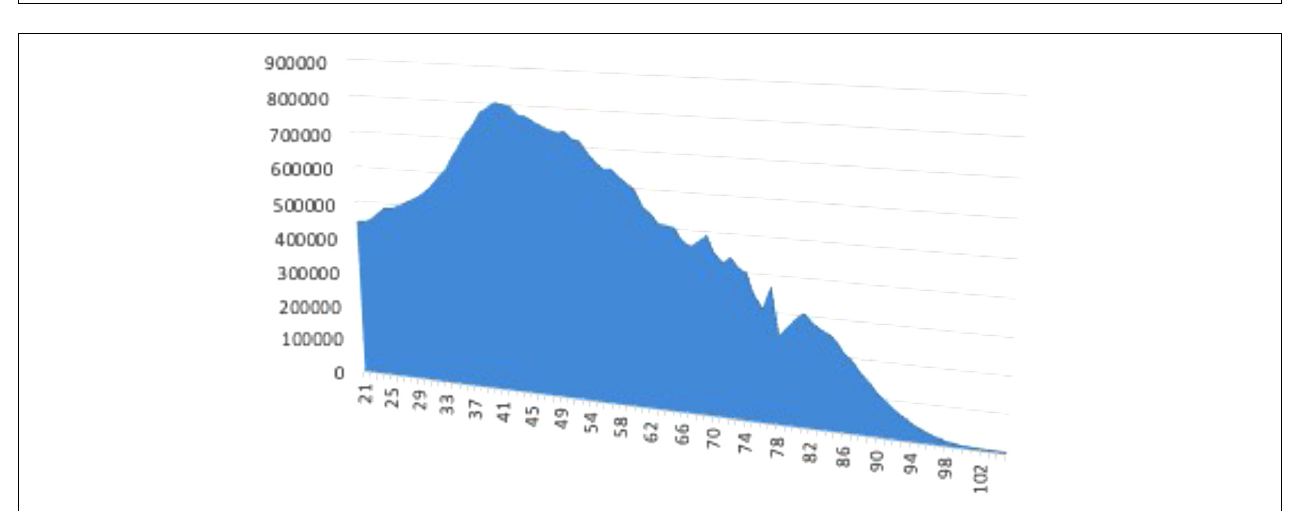
FIGURE 3 | Spanish age distribution pyramid, population over the age of